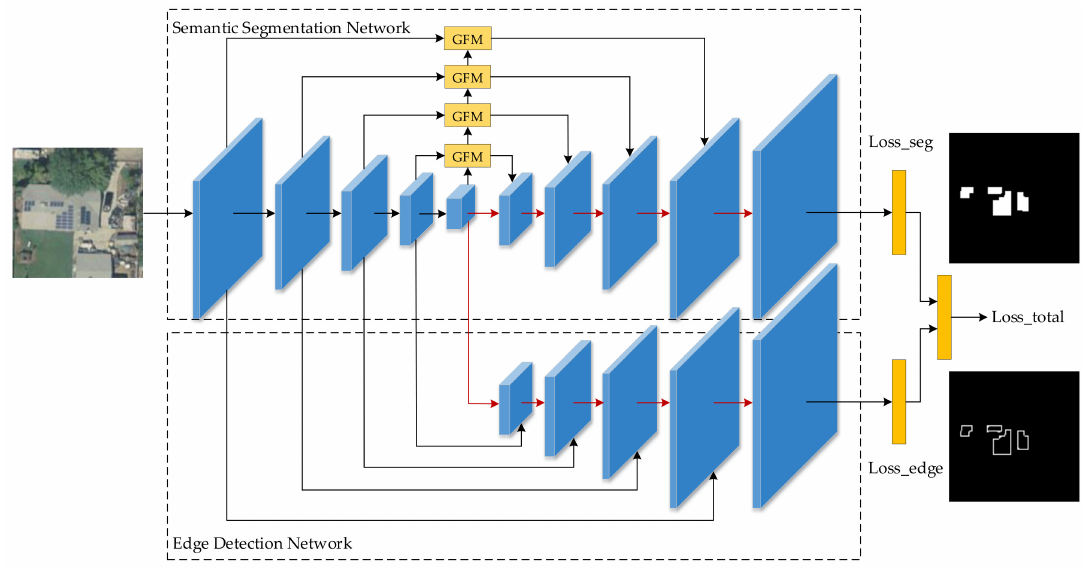
Figure 1. Structure of the proposed